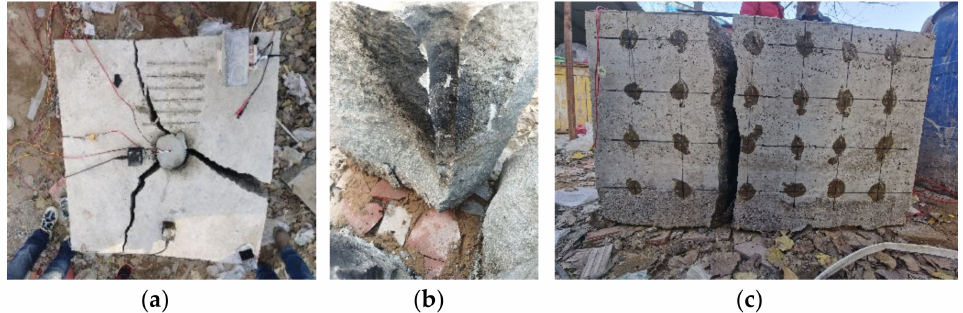
Figure 7. ( a ) Destruction pattern of the upper surface of test block.; ( b ) Destruction pattern of the borehole.; ( c ) Destruction pattern of the side of test